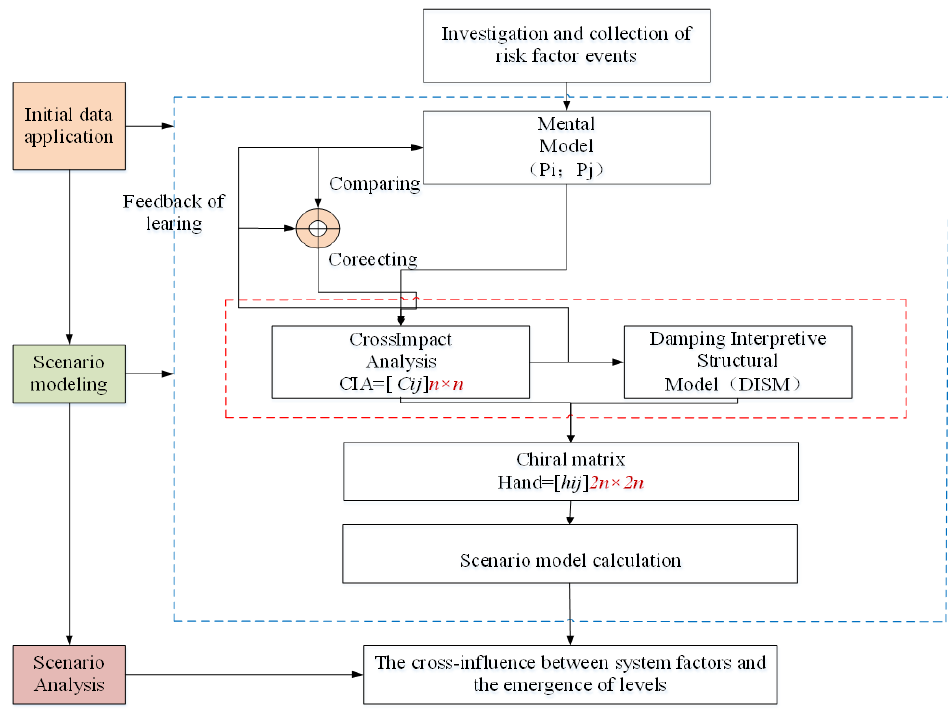
Figure 1. The process of CIA-DISM.